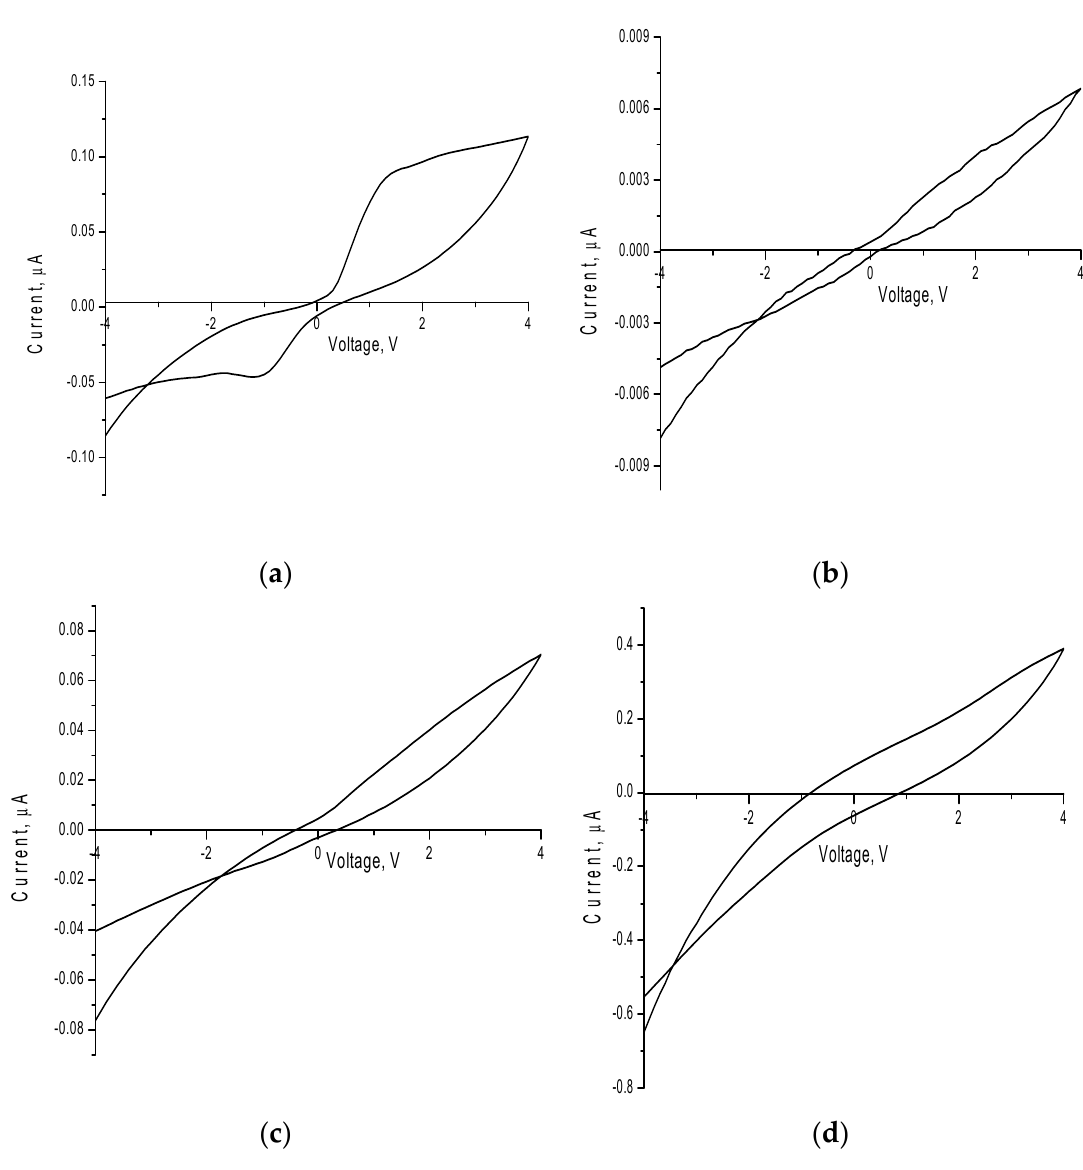
Figure 10. Graphs of cyclic voltammograms of the studied nanoparticles: ( a ) FeCeO x nanoparticles; b ) 0.9FeCeO x + 0.1Nb 2 O 5 nanoparticles; ( c ) 0.8FeCeO x + 0.2 Nb 2 O 5 nanoparticles; and ( d ) 0.7FeCeO x + 0.3 Nb 2 O 5 nanoparticles.